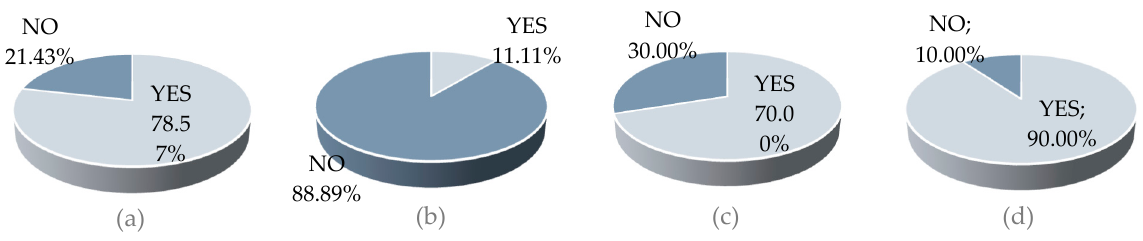
Figure 3. Responses to the questions: ( a ) “Do you use BIM for health and safety processes in your company?” ( b ) “Do you use BIM for hazard detection during the design processes?” ( c ) “Do you use BIM for hazard detection during construction preparation?” ( d ) “Do you use BIM for hazard detection during construction?”